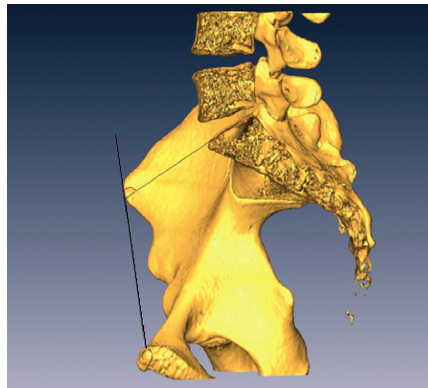
Figure 1: Sacral anatomic